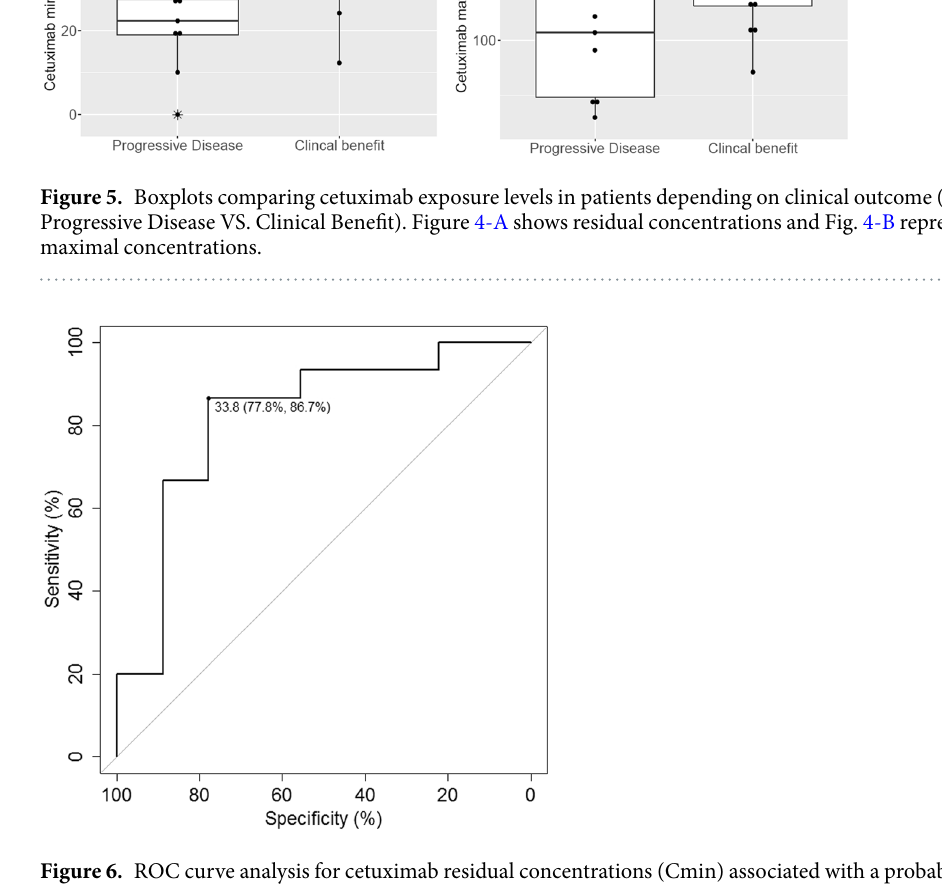
Figure 6. ROC curve analysis for cetuximab residual concentrations (Cmin) associated with a probability of clinical